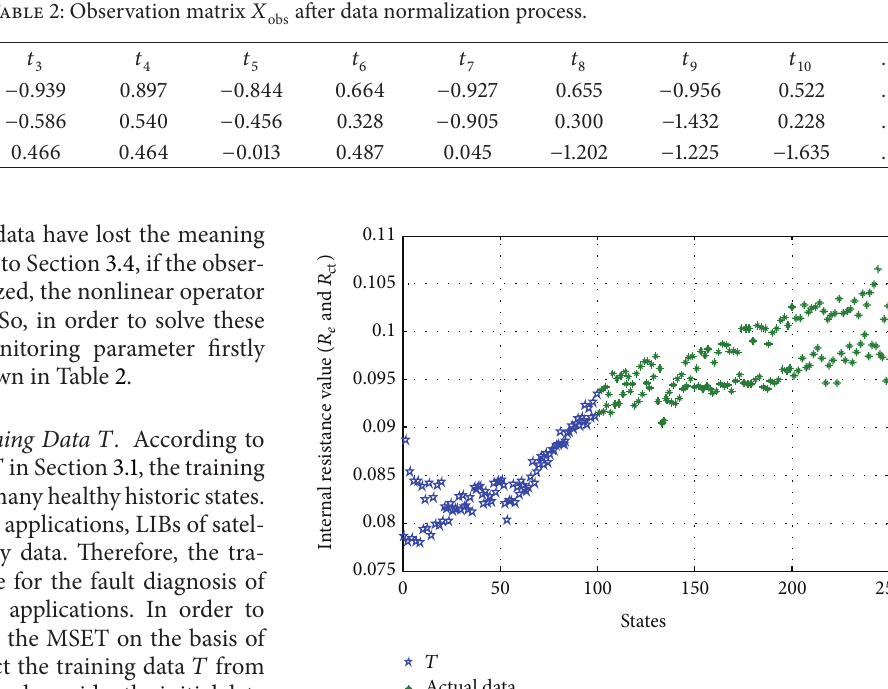
Table 2: Observation matrix 𝑋